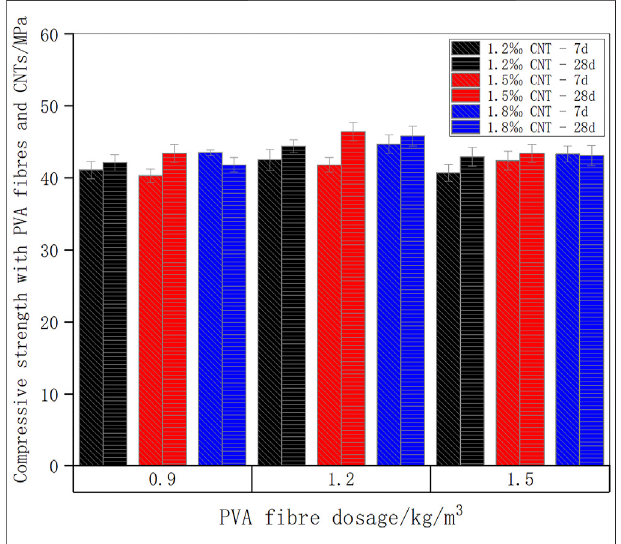
Frontiers in Materials |